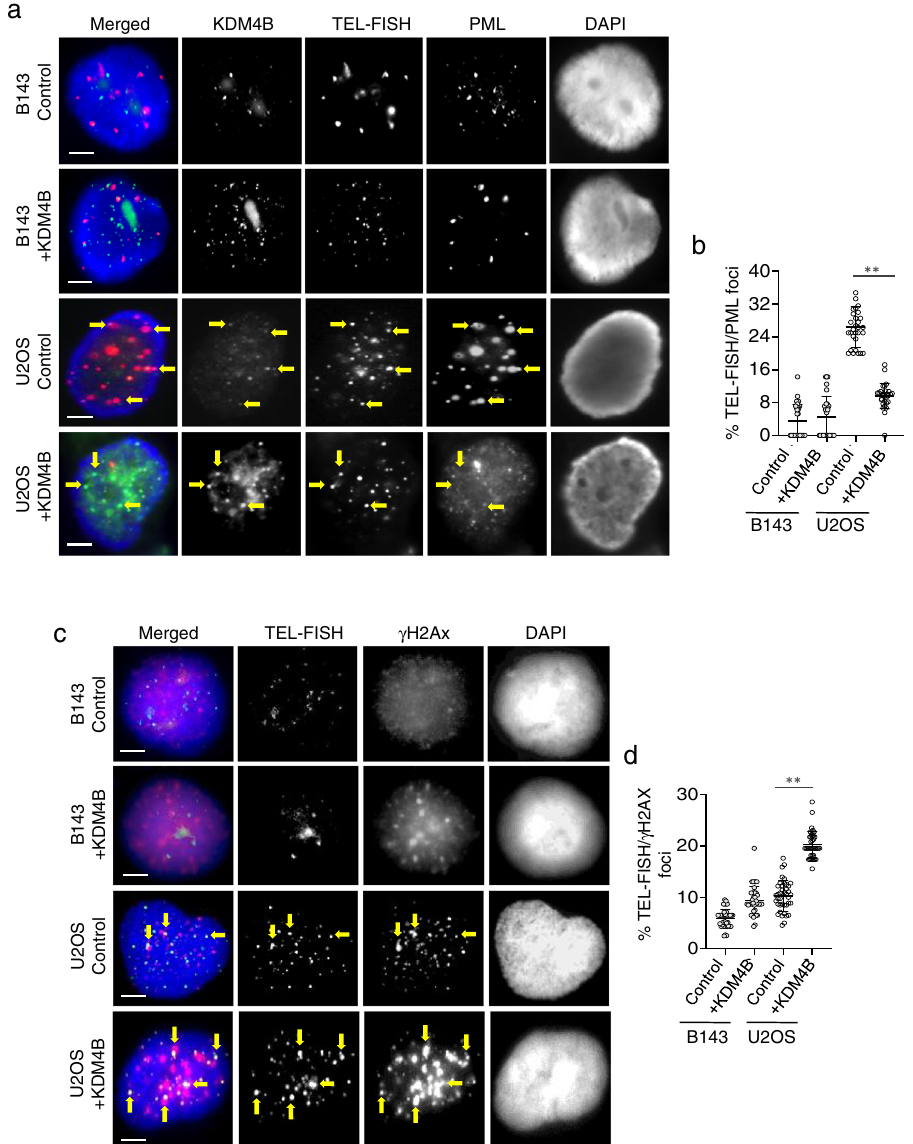
Fig. 4 KDM4B activity inhibits the ALT pathway. Immunostaining of KDM4B (green), PML (red) and TEL-FISH (cyan) in control or KDM4B transfected B143 and U2OS cells. Arrows show KDM4B at telomeres ( a ). Percentages of co-localised TEL-FISH and PML foci in H3.3 G34R APT-tKO#1 cells are shown in b ( n = 3 independent experiments; >500 foci counted). Immunostaining of γ H2AX (red; diluted at 1/500) and TEL-FISH (green) analyses in B143 and U2OS cells with and without overexpression of KDM4B ( + KDM4B). Arrows show γ -H2AX at telomeres ( c ). Percentages of co-localised TEL-FISH and γ H2AX foci are shown in d . For each cell line, >1500 telomeric or TEL-FISH telomeric foci were counted ( n = 4 independent experiments). Percentage of co-localised TEL-FISH/ γ H2AX foci are determined as percentages of telomeric foci that co-stained with γ H2AX over the total number of telomeric foci counted. b , d Data are presented as mean values ± SD. **indicates p < 0.005, Student ’ s t -test with two-tailed distribution. a , c Scale bars: 5 μ m; representative images from at least n = 3 independent experiments. Source data are provided with this